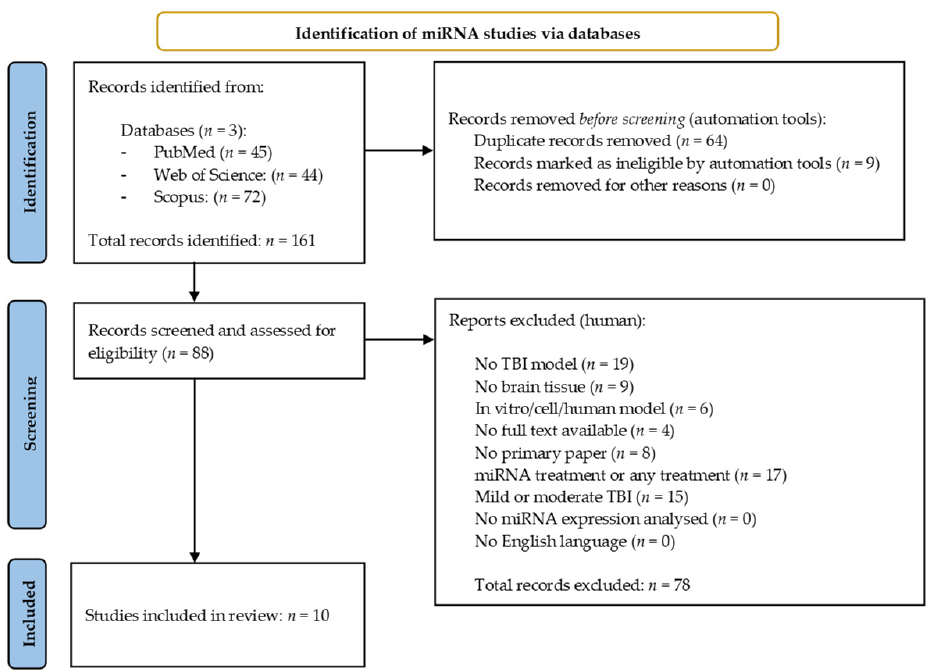
Figure 1. Preferred reporting items for systematic reviews and meta-analysis (PRISMA) flow chart detailing the literature search process for miRNA studies.